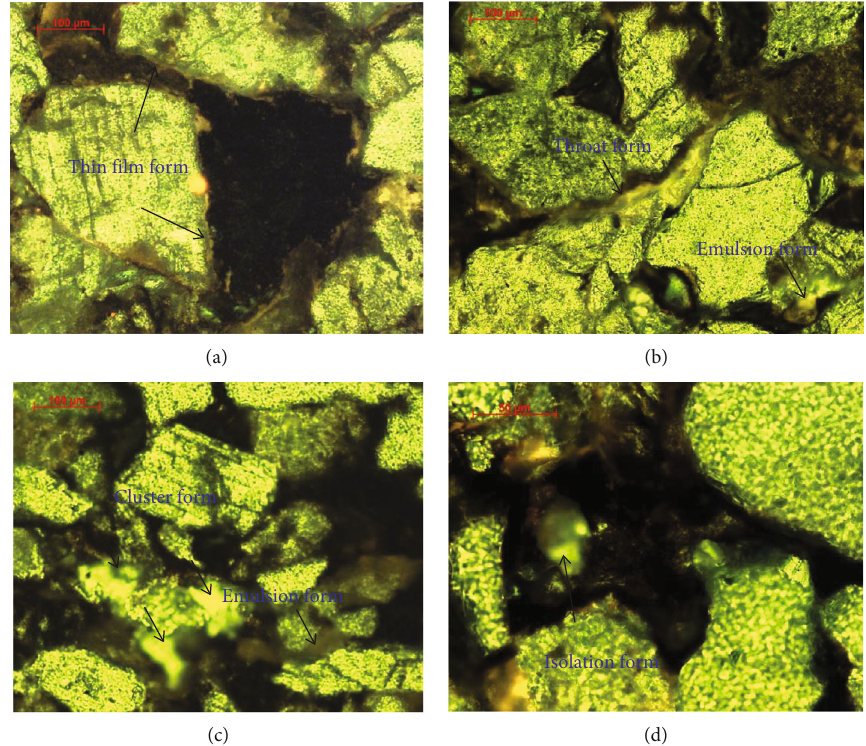
Figure 5: Classi fi cation of the absorbed tight oil occurrence forms. (a) Chlorite and iron calcite surface absorbed thin fi lm form oil (B280- 13-3). (b) Throat form in throat and cluster form in cements (B436-7-33). (c) Emulsion form in interparticle pore and cluster forms in feldspar dissolved pore (B455-2-60). (d) Isolation form in the intracystalline pore (B456-6-06). Table 3: Data of rock density and porosity permeability change before and after Soxhlet extraction.